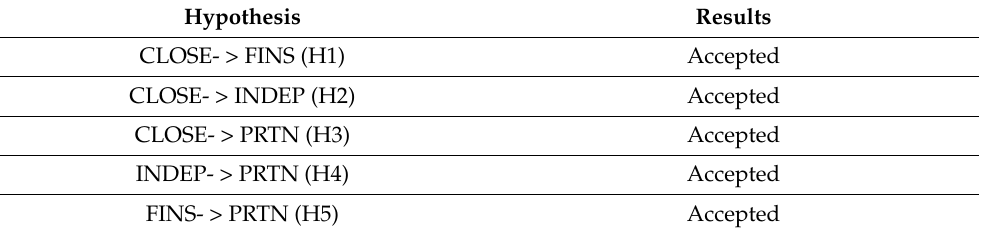
Table 7. Hypotheses validation.